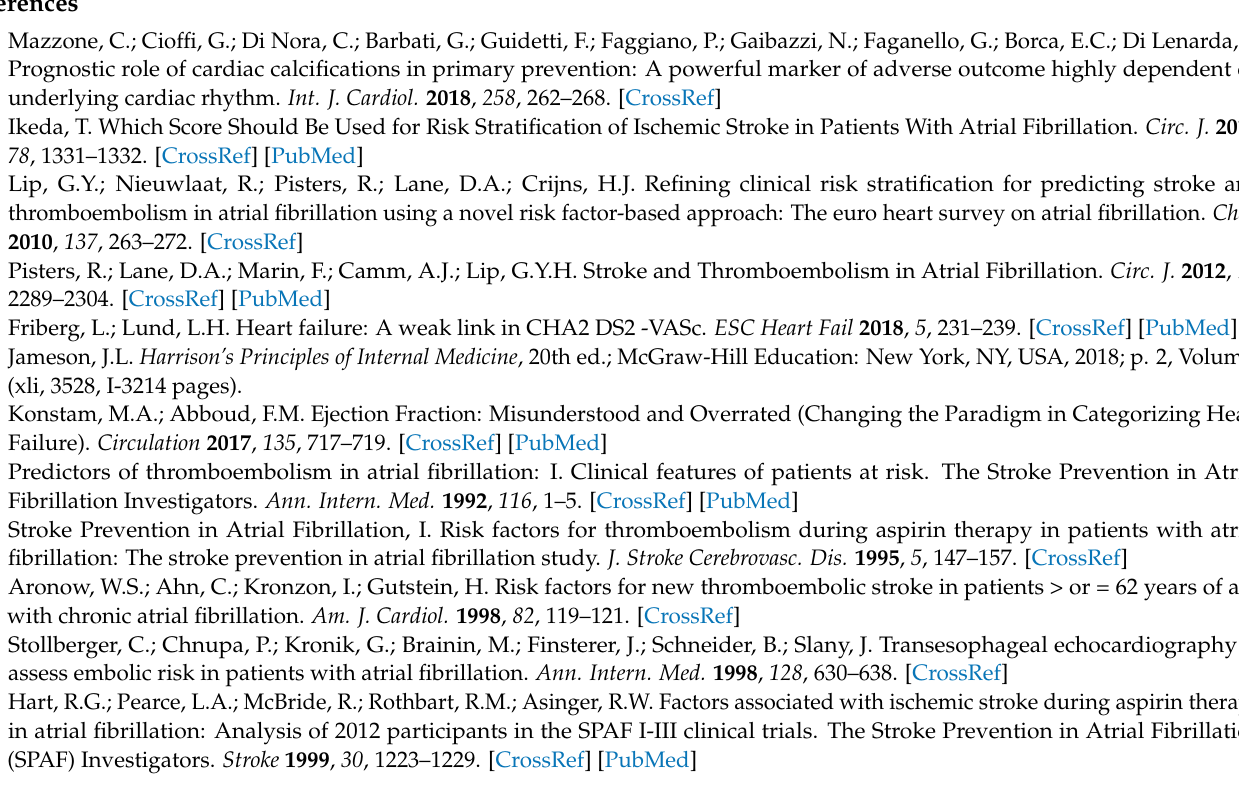
CATE; Table S3: Multivariable-adjusted Cox regression analysis of each CHA2DS2-VASc scores using different definitions for congestive heart failure in predicting composite thromboembolic events after excluding patients administered with anticoagulation; Table S4: C-statistics of different definitions used for congestive heart failure of the CHA2DS2-VASc scores in predicting composite adverse thromboembolic